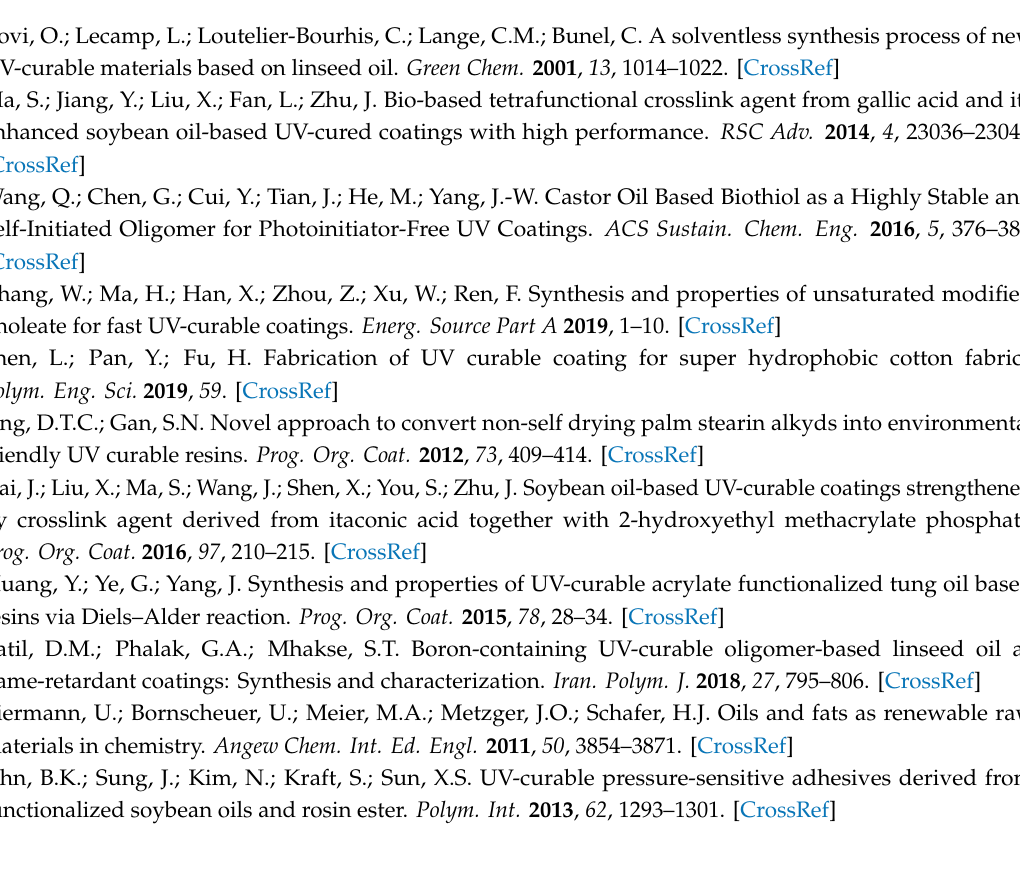
Figure S1: Acid values of MAAMA, Figure S2: FT-IR spectra of (a) ERSO, (b) MMERSO, (c) EWSO, and (d) MMEWSO, Figure S3: 1 H NMR spectrum of (a) ERSO, (b) MMERSO, (c) EWSO, and (d) MMEWSO, Figure S4: 1 H NMR spectrum of MAAMA, Figure S5: 1 H NMR spectrum of ESO, Figure S6: 1 H NMR spectrum of ERSO, Figure S7: 1 H NMR spectrum of EWSO, Figure S8: 1 H NMR spectrum of MMESO, Figure S9: 1 H NMR spectrum of MMERSO, Figure S10: 1 H NMR spectrum of MMEWSO, Figure S11: 1 H NMR spectrum of AESO, Equation (S1): Determining the grafted C = C functionality for